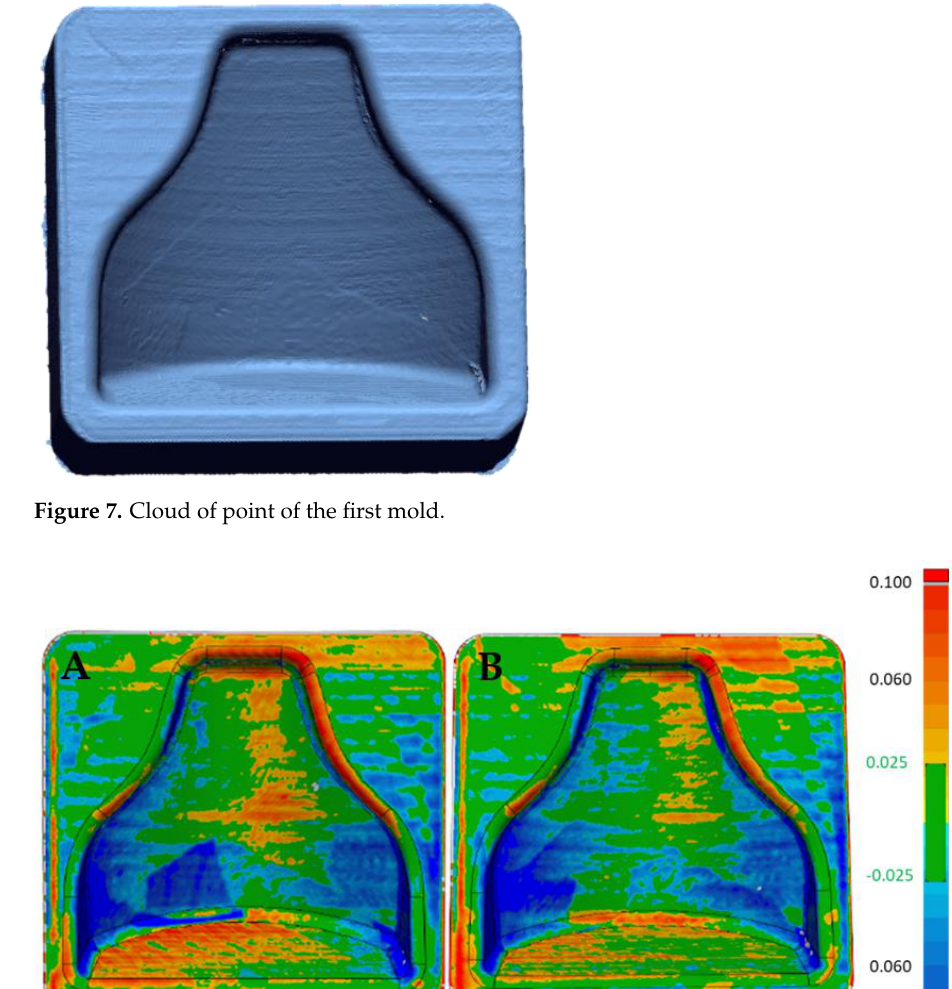
Figure 9. Zebra stripes effect on the two molds after printing, ( left ) mold 1 and ( right ) mold 2. Furthermore, Figure 10 shows the comparison between the two molds point-clouds with each other. It could be seen that the reproducibility of printing with this specific ma- terial was very high. In fact, the two molds could be superimposed, as can be seen from the almost complete green color of the image.